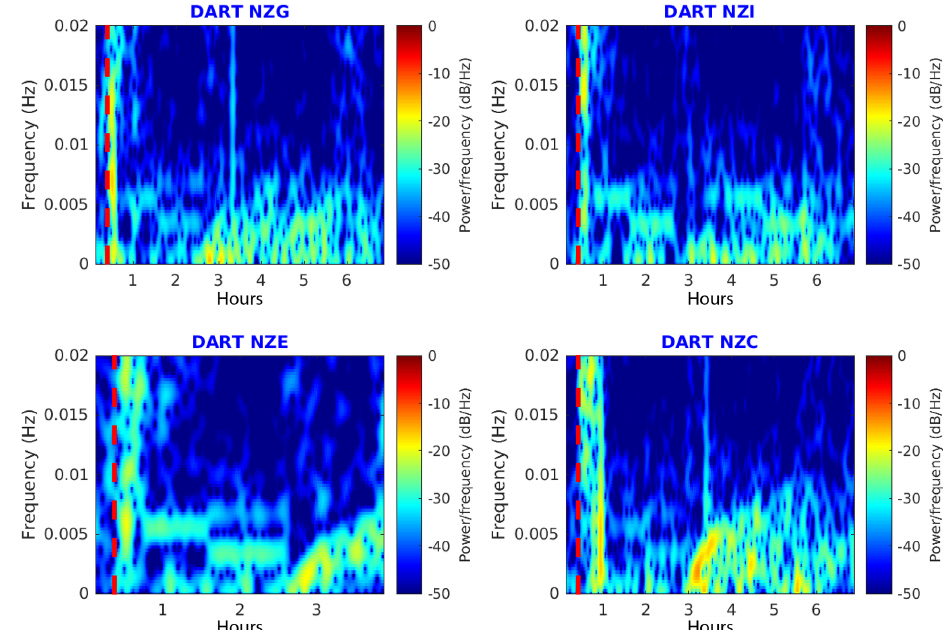
Figure 6. Wavelet spectrograms for the 10 February 2021 Loyalty Island tsunami recorded on New Zealand DART stations. The red dashed lines symbolize the earthquake